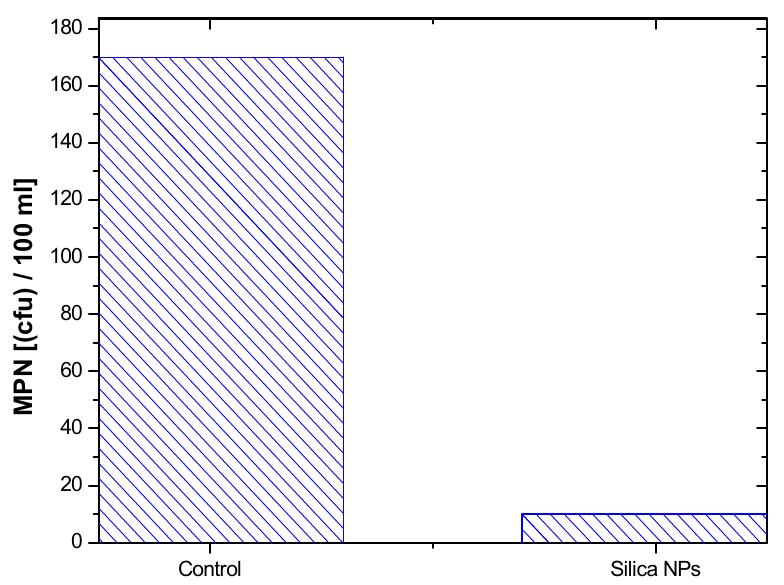
Figure 15. Antibacterial activity of the prepared silica nanoparticles against coliform bacteria as estimated by the MPN method.